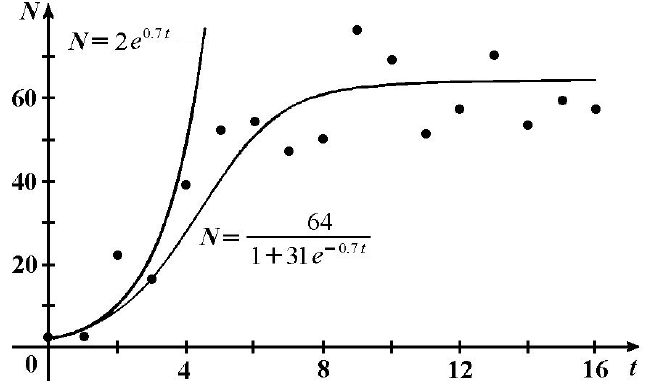
Figure 5. The behavior of growth in the Gause